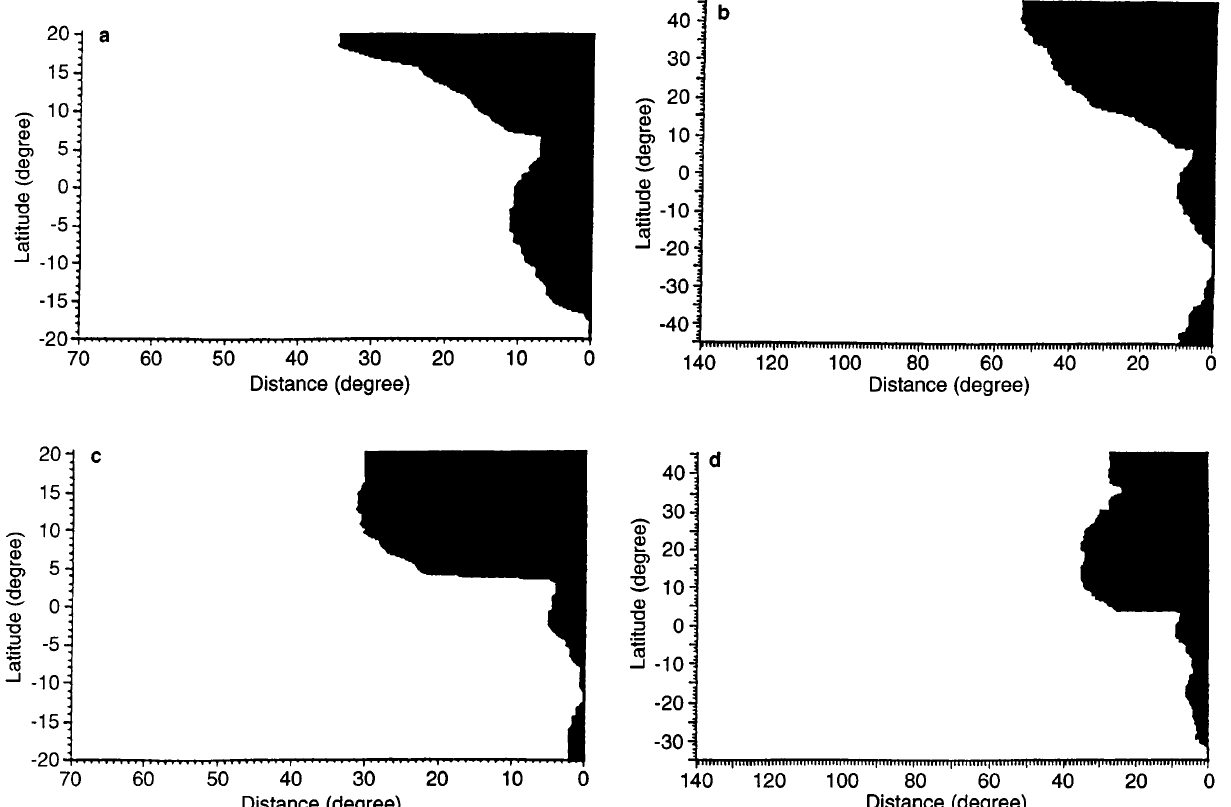
Fig. 1a–d. Model geometry. Pacific Ocean eastern coastline used for the a intraseasonal experiment and b for the seasonal and annual experiments; Atlantic Ocean eastern coastline used for the c intraseasonal experiment and d seasonal and annual